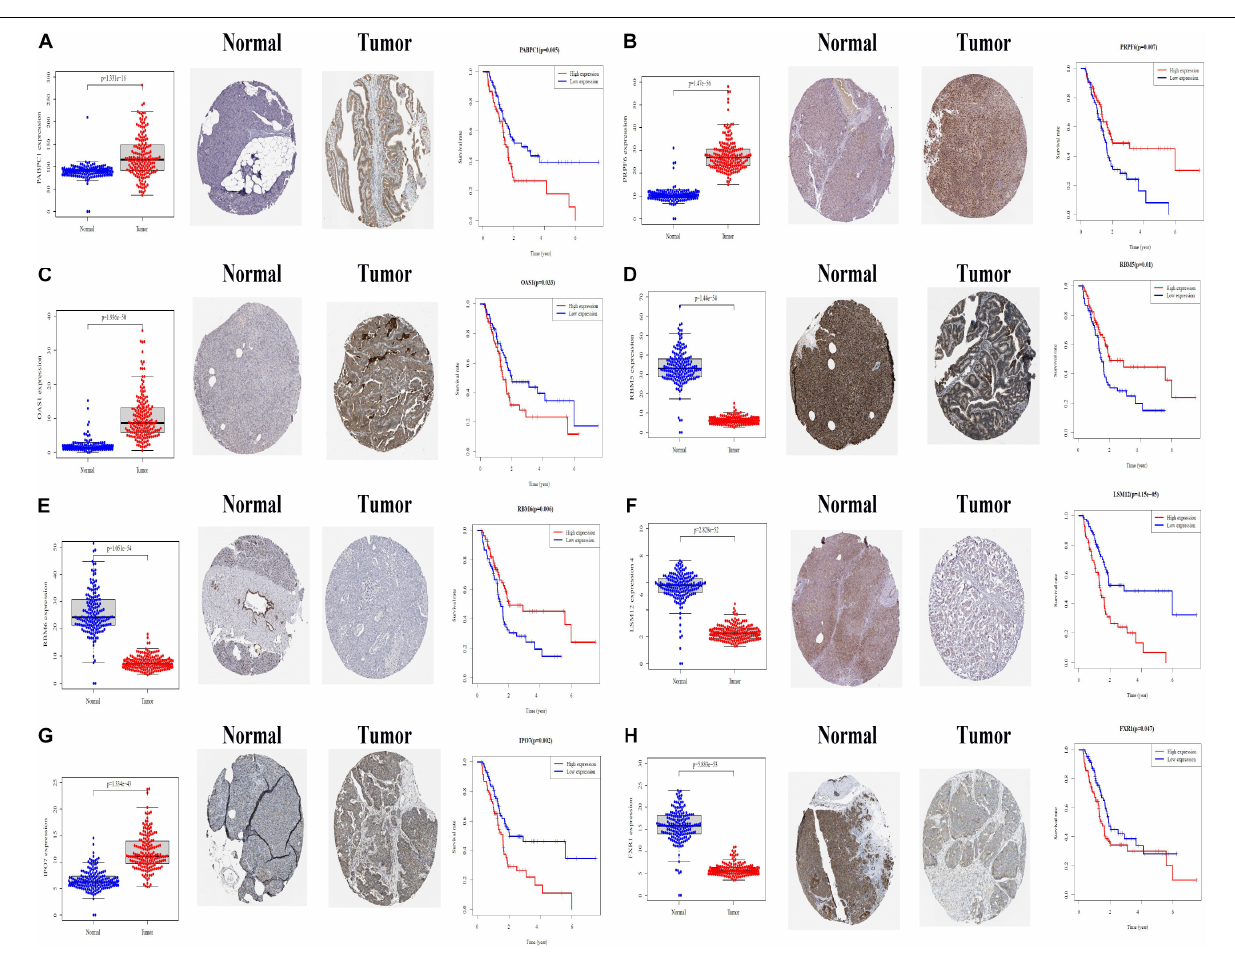
that these DE-RBPs are mainly enriched in RNA